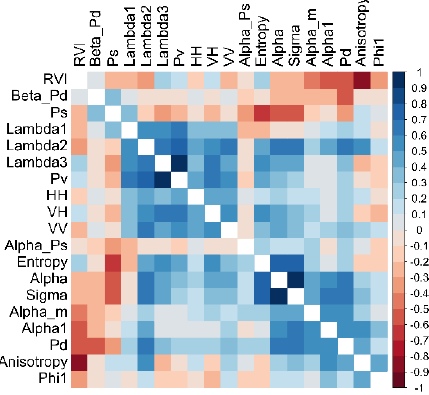
Figure 5. Correlation among different polarimetric parameters.